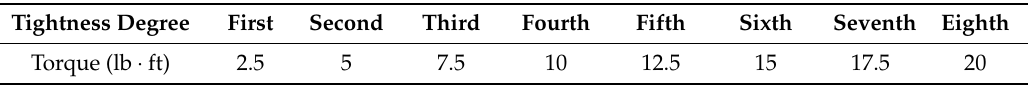
Table 2. Torque values at different tightness